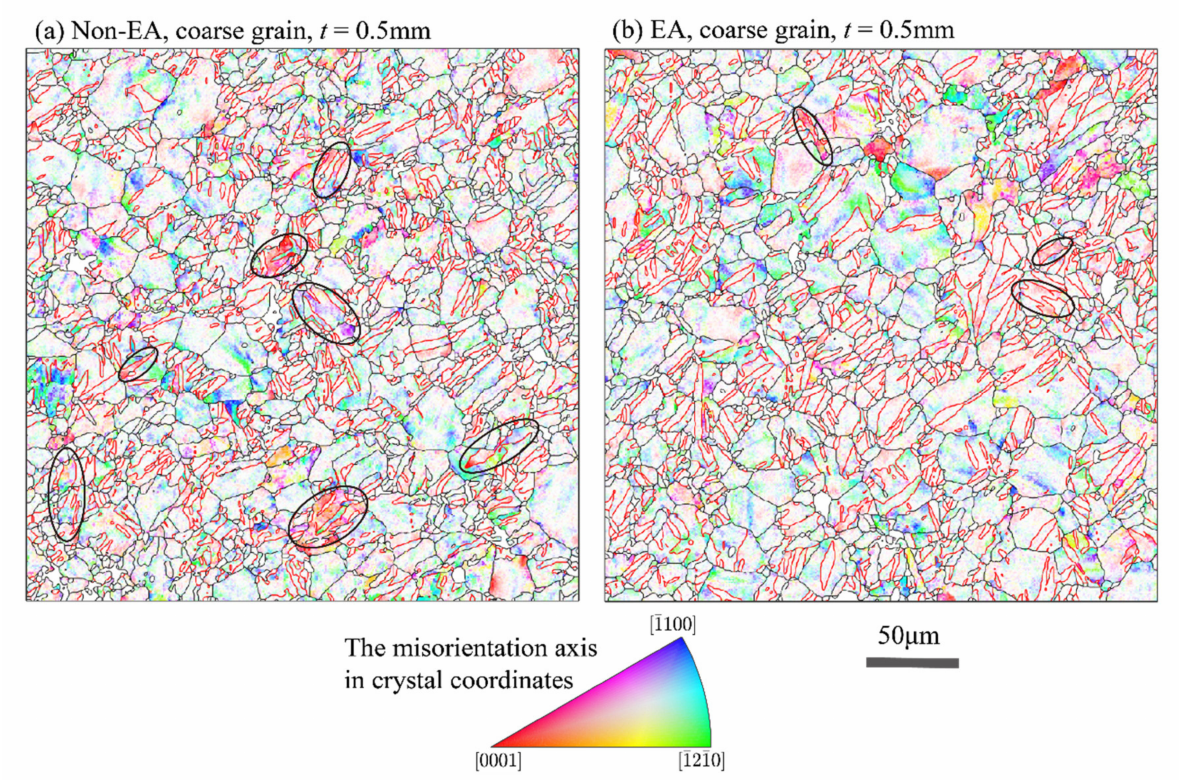
Figure 8. The grain reference orientation deviation (GROD) axes in crystal reference frame overlaid with grain boundaries (black lines) and extension twin boundaries (red lines) of the non-EA and EA samples strained to 10% tensile deformation. Misorientation axis vectors were colored with the hexagonal symmetry IPF, showing the axis as a direction in the HCP unit